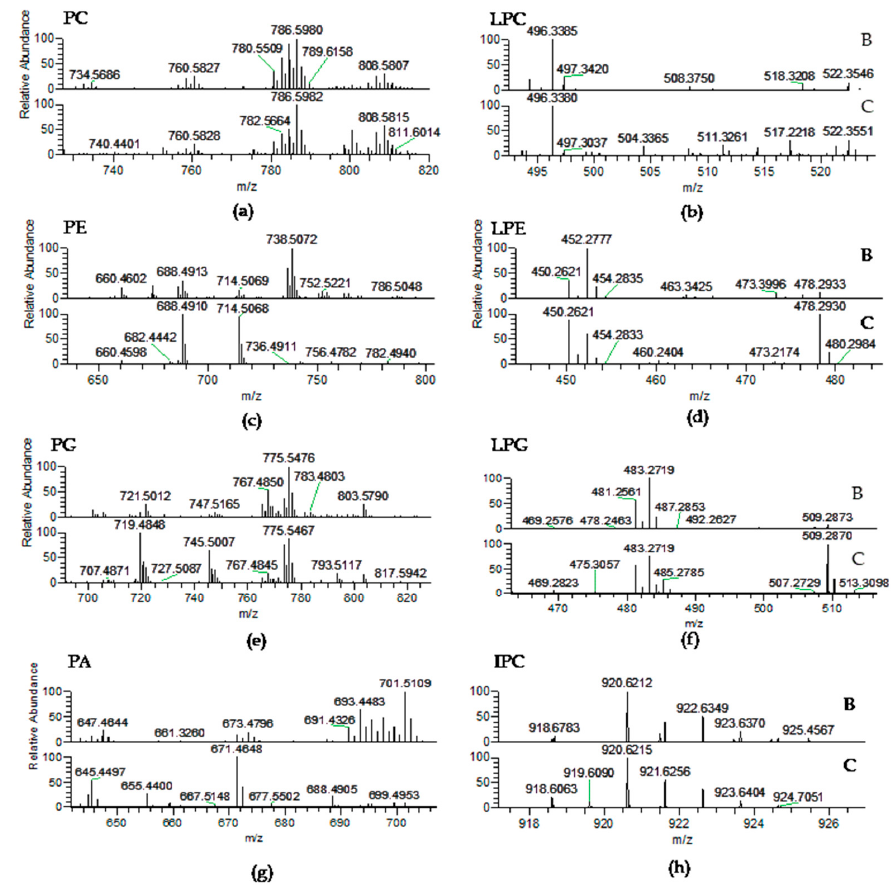
Figure 3. LC–MS spectra of phospholipid classes: ( a ) Phosphatidylcholine (PC); and ( b ) Lyso-PC